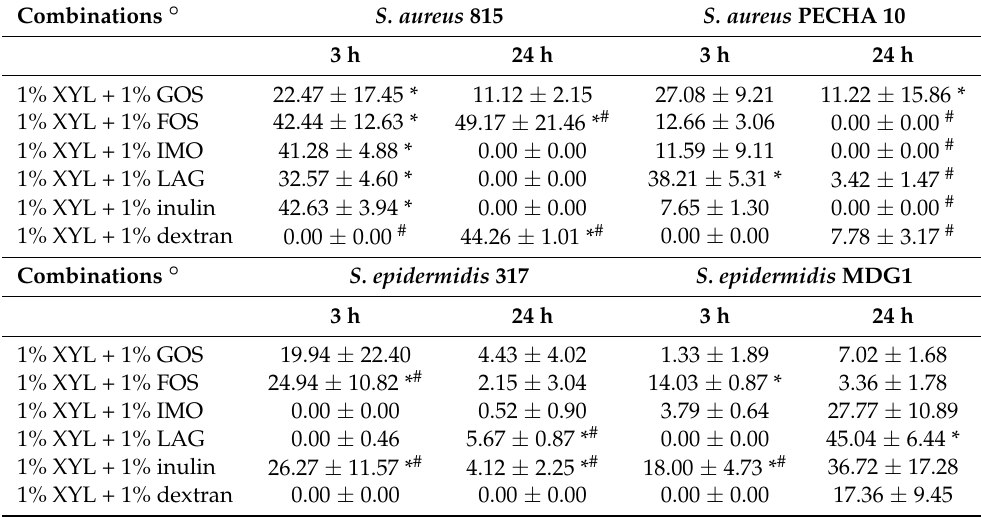
Table 2. Percentage of planktonic S. aureus 815, S. aureus PECHA 10, S. epidermidis 317 and